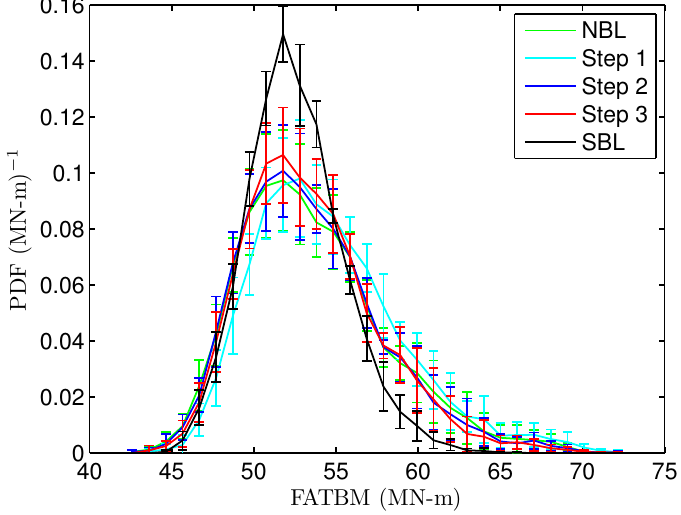
Figure 23. Probability density functions for the base fore-aft tower bending moment, FATBM, for a single case